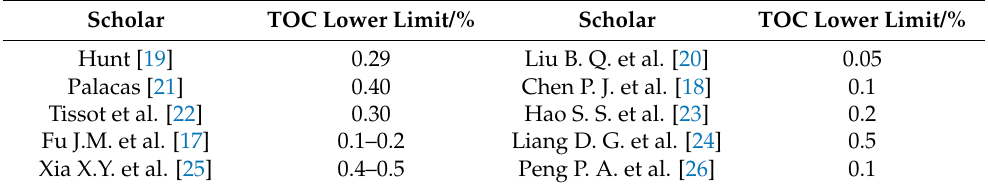
Table 1. TOC lower limits of TOC carbonate source rocks proposed in various